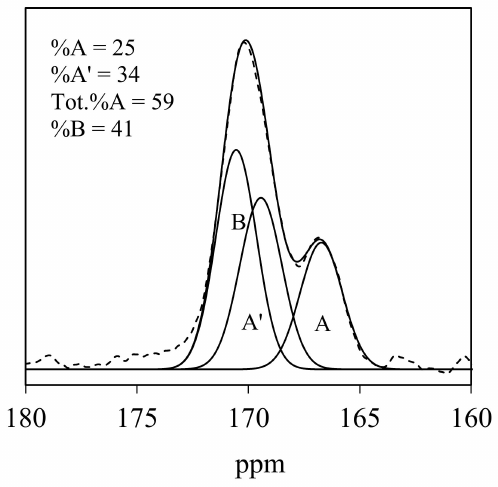
Figure 7. The 13 C MAS solid-state NMR spectrum of KS-117, containing no Eu 3+ .